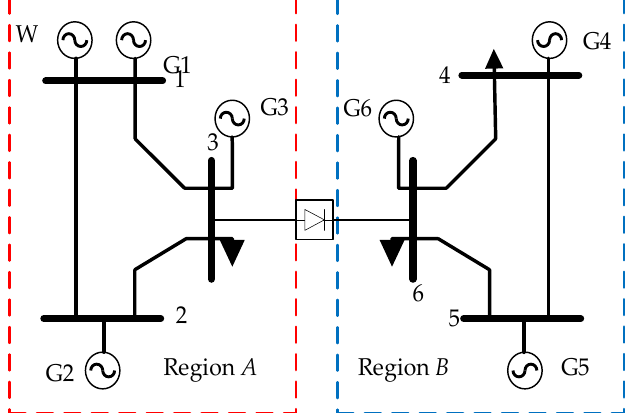
Figure 8. The structure of the two-region 6-node interconnected power system.